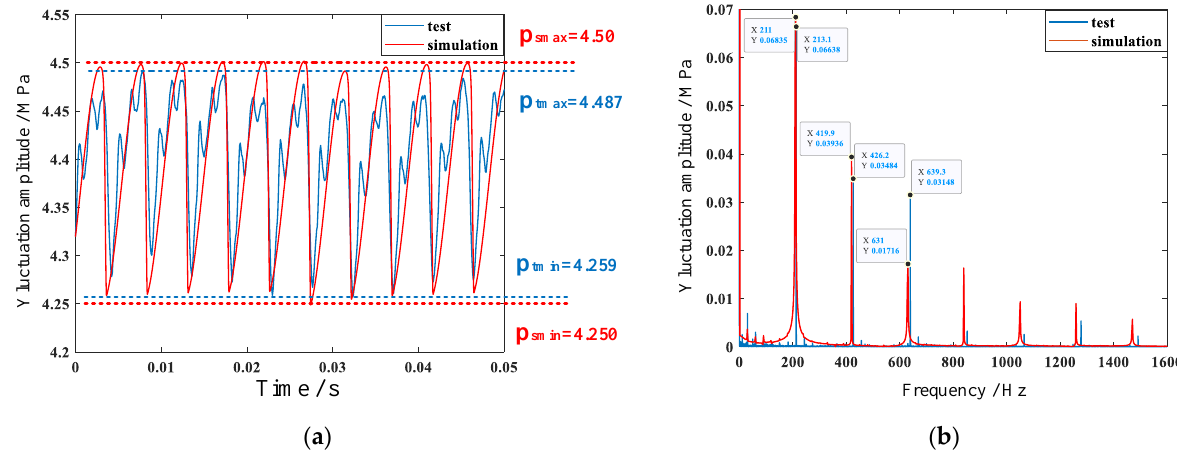
Figure 15. Comparison of the simulation and experiment results. ( a ) Time domain comparative analysis chart; ( b ) frequency domain comparative analysis chart.